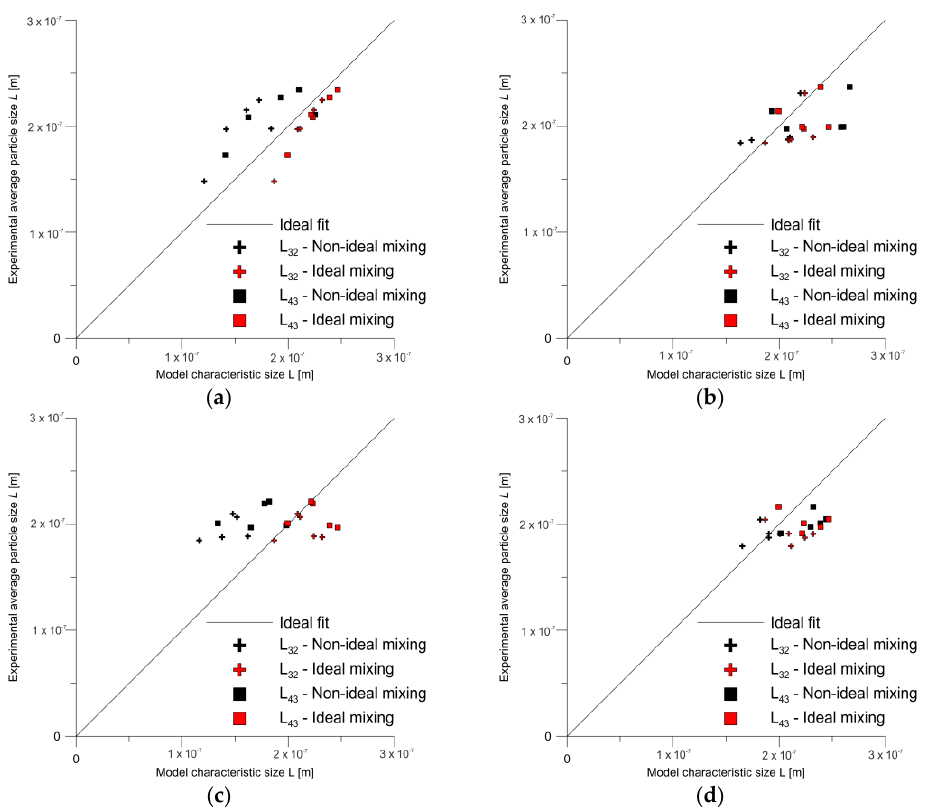
Figure 14. Parity plots for V-type reactor at ( a ) 20 and ( b ) 50 mL/min flow rates and for T-type reactor at ( c ) 20 and ( d ) 50 mL/min flow rates.